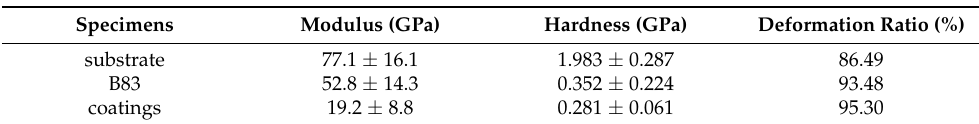
Table 5. The modulus, hardness, and deformation ratios of the substrate, Babbitt B83, and the running-in coatings of specimen